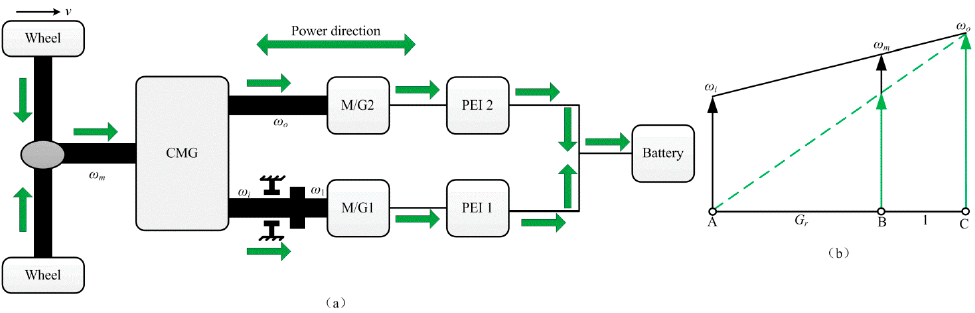
ω ω= = ; ( b ) Speed relationship. 0 1 i